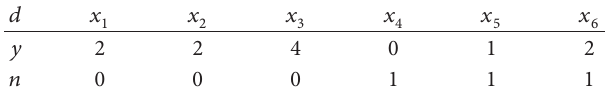
Table 9: The number of different classes.